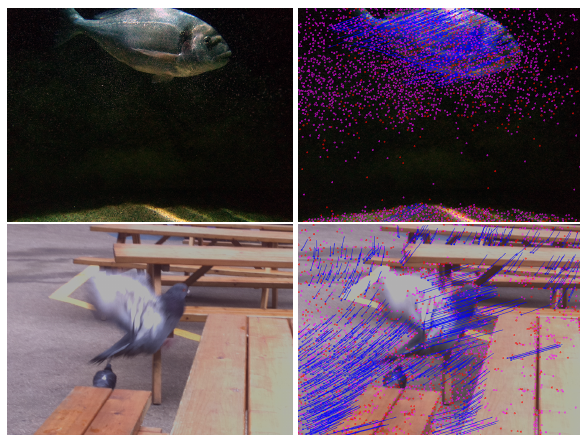
Figure 8. Example of matching result for synchronised pair with fauna: the pair of fish (top) offers 38% of inliers (small part of the image) and the pair of bird (bottom) offers 42% of inliers.